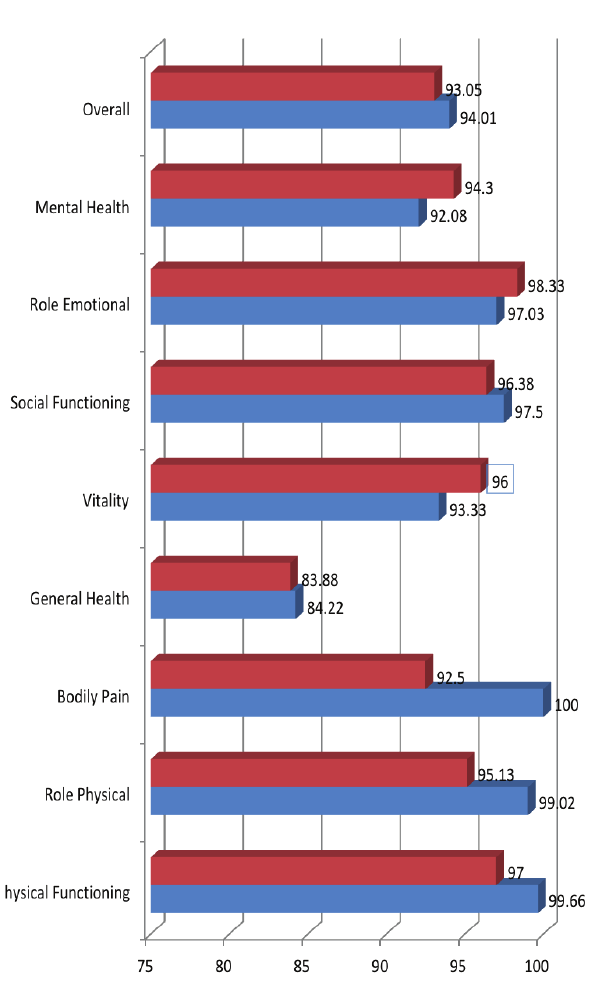
Table 1: SF36 QOL scores before donor nephrectomy